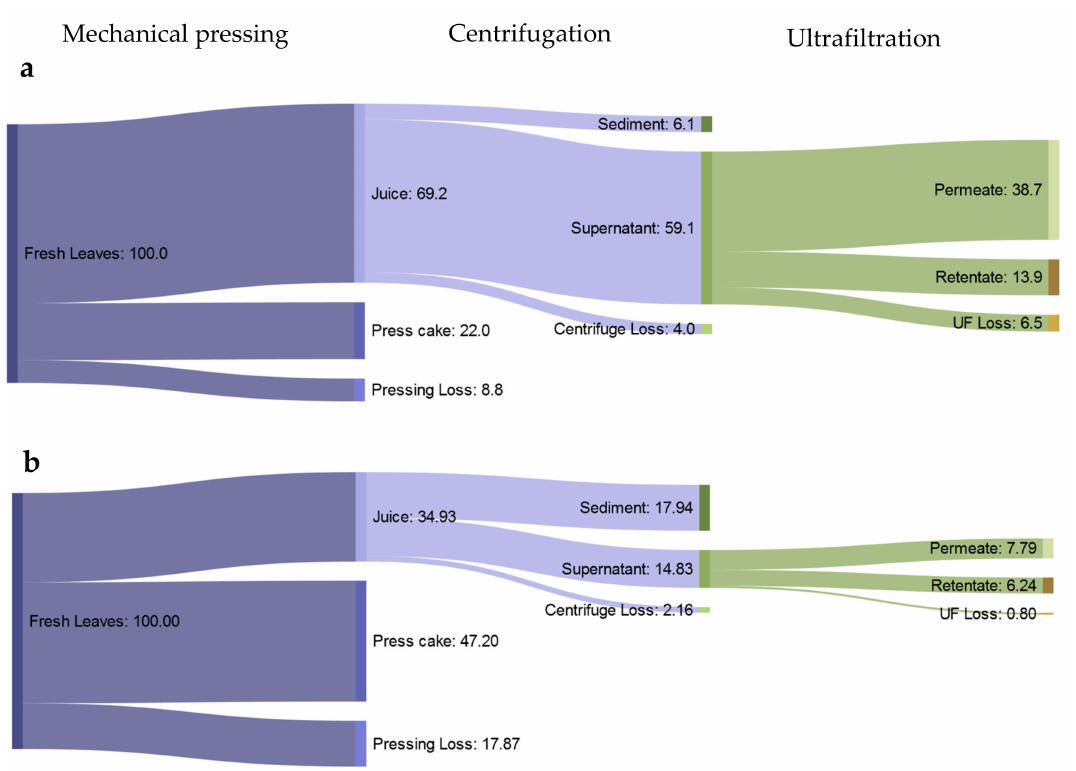
Figure 2. ( a ) Mass balance and ( b ) protein yield (%) of cassava leaf processing fractions after mechanical pressing, centrifugation, and ultrafiltration (UF) on a fresh matter